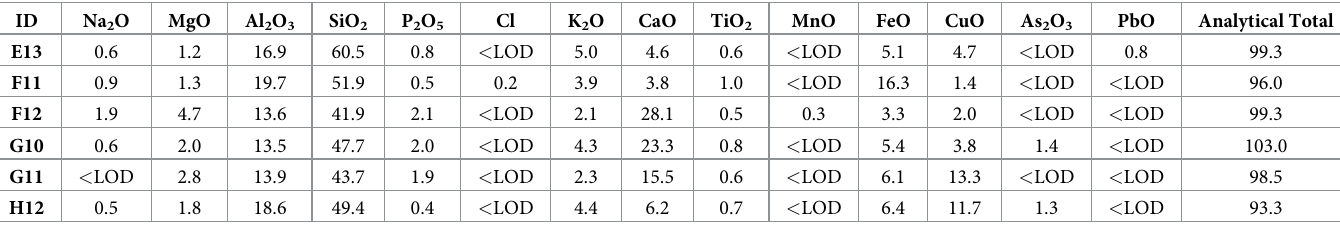
Table 7. SEM-EDS results (wt%) of glassy matrix analyses. ID Na 2 O